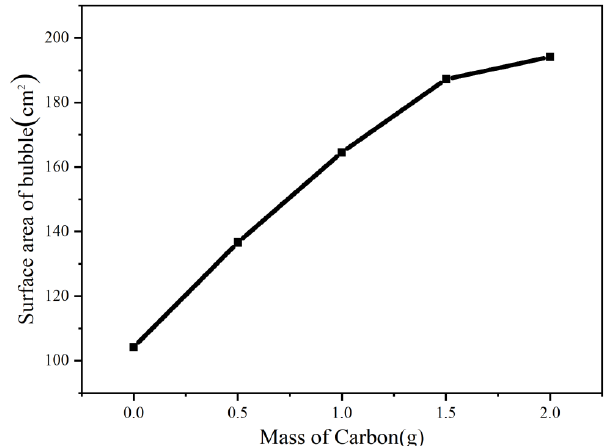
Figure 5. The changing trend of bubble size.